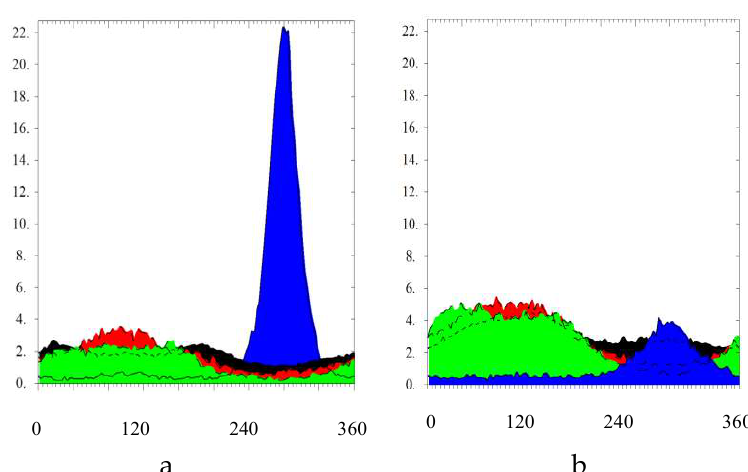
Figure 19. Texture integrated and normalized intensities of the four main crystallographic planes. ( a )—after 1 pass (~A), ( b )—after 9 passes B C . Colors are for: blue (002), red (100), black (101), and green (110) lines.